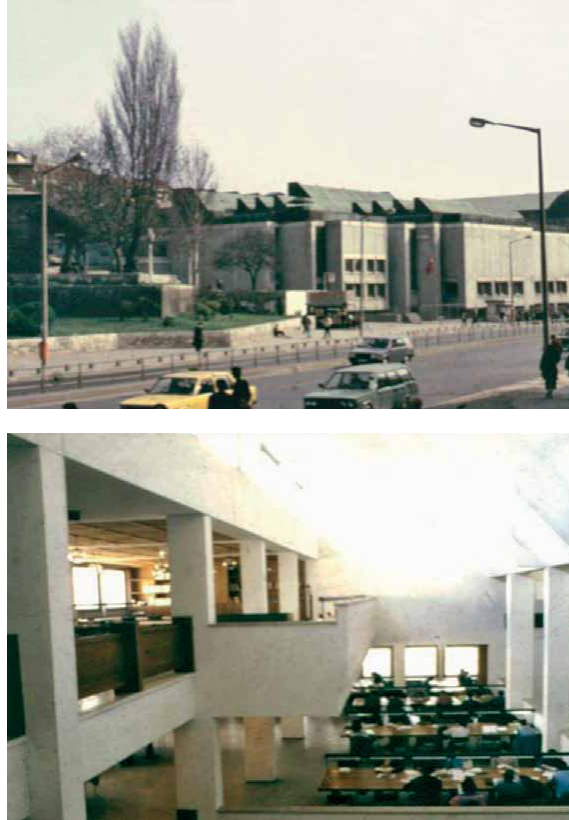
fig. 14. Istanbul university library (from Sevinc Hadi’s